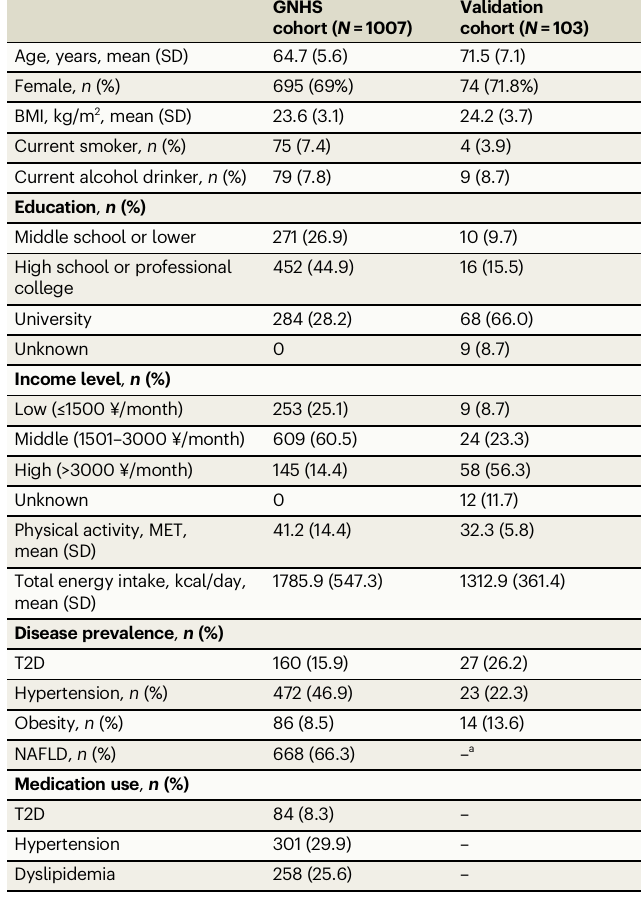
Table 1 | Characteristics of the study